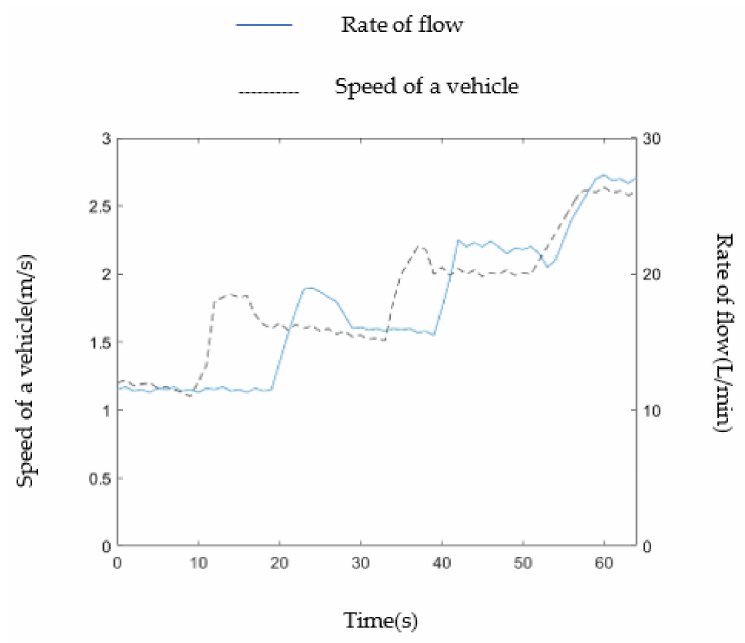
Figure 18. Test results of liquid manure flow by fuzzy PID